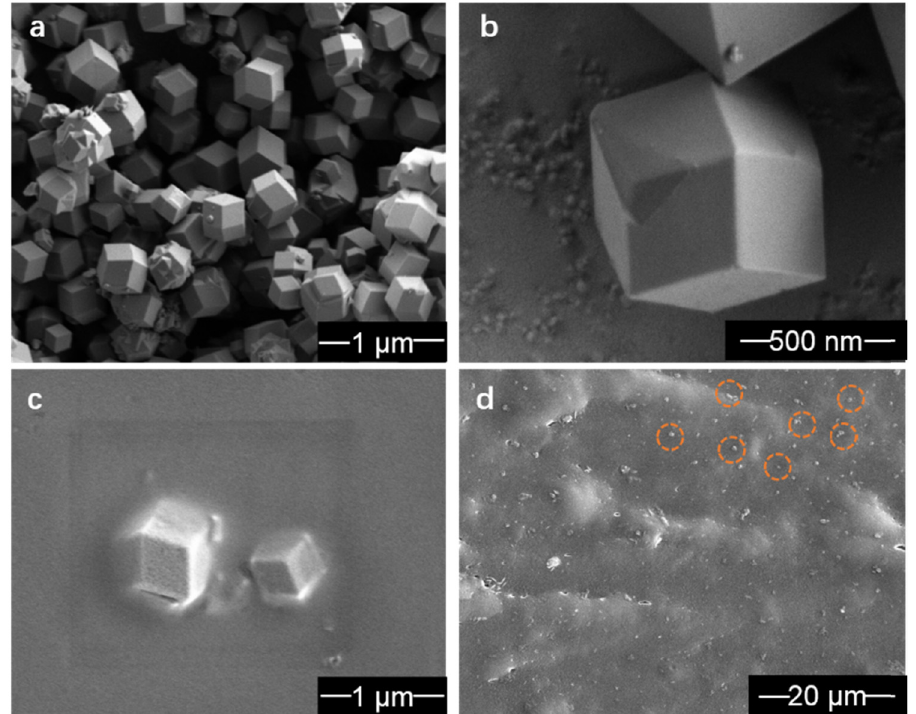
Figure 1: SEM images of ( a and b ) ZIF - 67 and ( c and d ) ZIF - 67@EP.